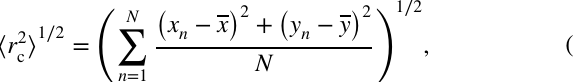
tank. Figure 6a, d, g show the centroid distribution of the